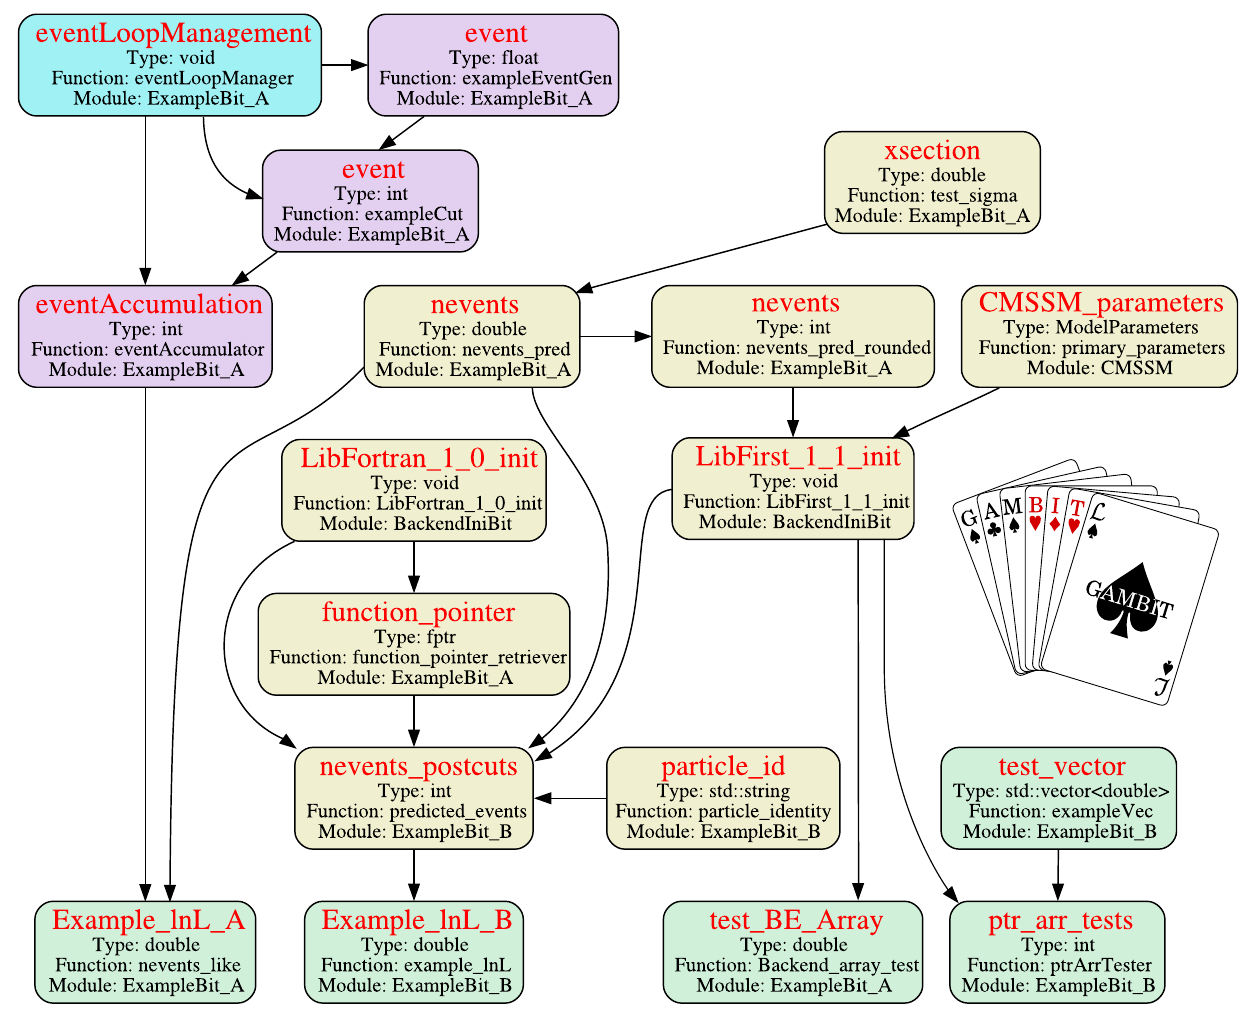
Fig. 5 An example dependency tree generated in the initialisation stage of a GAMBIT scan. Each block corresponds to a single mod- ule function , with the red text indicating its capability . Arrows indi- cate resolution of dependencies of different module functions with the results of others. The functions selected by the dependency resolver to provide the observables and likelihoods requested in the ObsLikes section of the scan’s input YAML file are shaded in green. Module